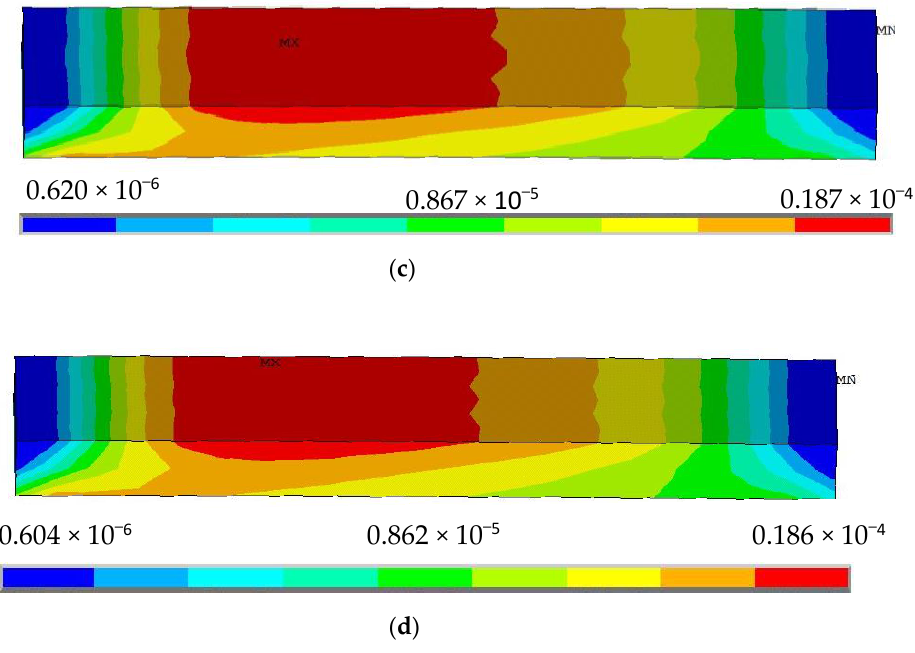
Figure 4. Stress distribution nephogram of silica gel with different widths: ( a ) D = 25 mm, ( b ) D = 15 mm, ( c ) D = 10 mm, ( d ) D = 8 mm.